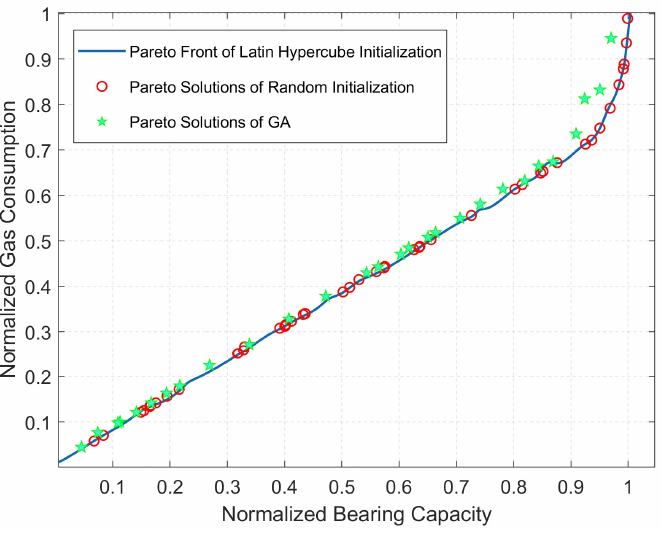
Figure 13. Pareto solutions obtained after the 60th generation.